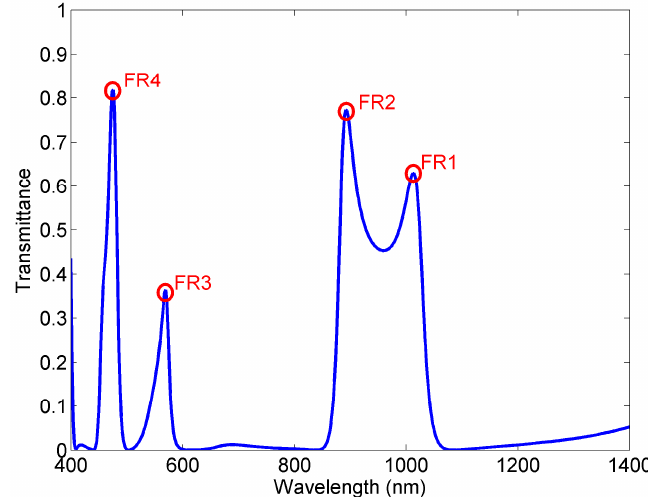
Figure 2. Transmission spectrum of the proposed Fano MIM sensor.